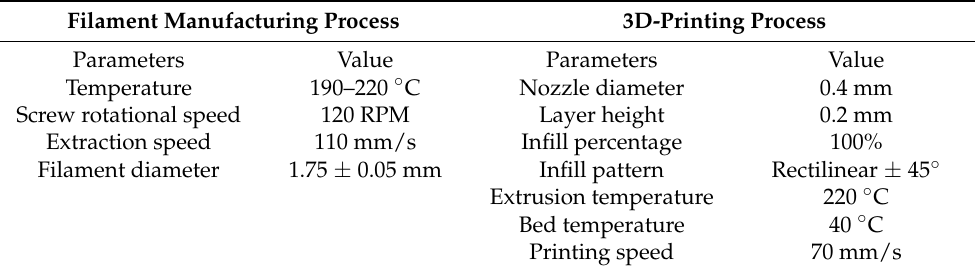
Table 2. Parameters of filament manufacturing and 3D-printing process.